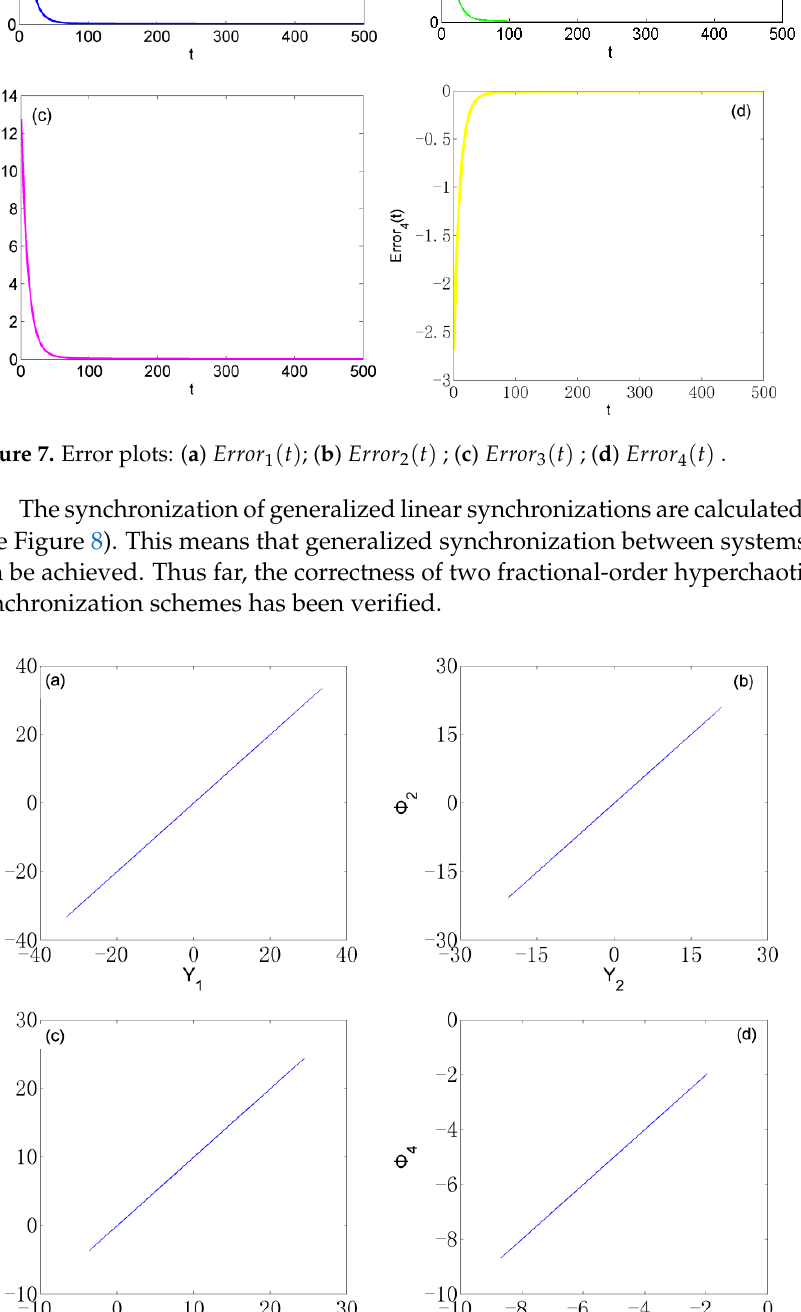
Figure 8. Synchronization plots of the generalized linear synchronization. ( a ) φ 1 and Y 1 ; ( b ) φ 2 and